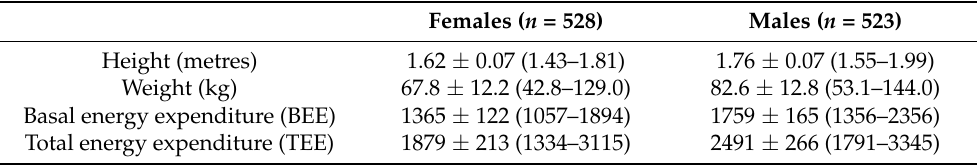
Table A1. Input data and calculated values for the energy sub-score, with penalties for over- and under-consumption.